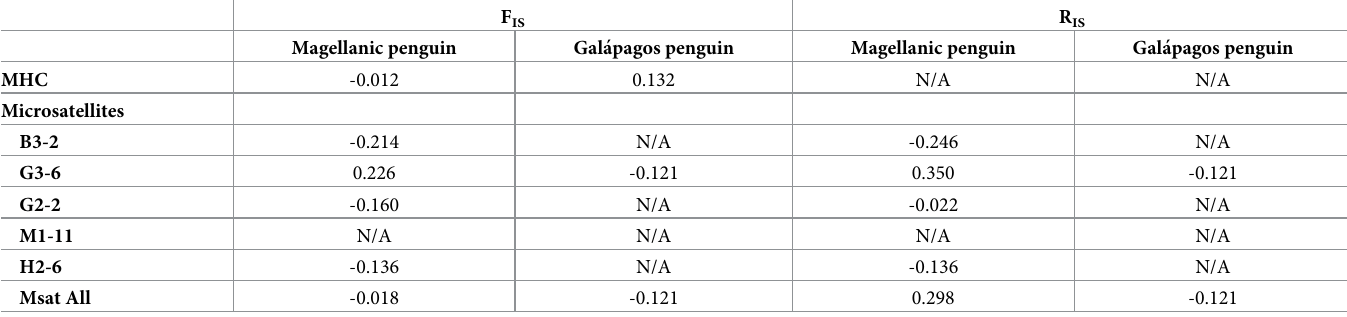
Magellanic penguin alleles (i.e., none of the alleles were shared between the two species). There were 37 polymorphic sites in the Magellanic penguin MHC alleles, whereas the Gala´pagos pen- guin MHC revealed only nine polymorphic sites (Table 1). The two alleles from the Gala´pagos penguin were found at relatively high frequencies (0.605 and 0.395). The observed heterozy- gosity was significantly higher in the Magellanic penguin (0.923) compared to that of the Gala´- pagos penguin (0.421), although there was no deviation from Hardy-Weinberg equilibrium observed for either sample set (both P > 0.5, Table 1). However, the F for the Magellanic pen- IS guin was -0.012 and for the Gala´pagos penguin was 0.132, a trend consistent with expectations for large, outbred versus small, possibly inbred populations (Table 2). Analysis of Magellanic penguin MHC sequences revealed higher rates of nonsynonymous ( d ) than synonymous ( d ) substitutions for the entirety of exon 2, and the PBR and non-PBR, N S resulting in d / d ratios significantly larger than one (all P < 0.01; Table 3). For the Magellanic N S penguin samples, the PBR had the highest d value (0.198), although this region also had the N highest d value (0.021), resulting in a d / d ratio of 9.429. Similar to the Magellanic penguin S N S samples, the Gala´pagos MHC had significantly higher d than d values along the entirety of N S exon 2 and for the PBR (both P � 0.01). Since there were no synonymous substitutions detected in the Gala´pagos penguin samples, we could not calculate a d / d ratio for this spe- N S cies. Similar to the Magellanic penguin, the Gala´pagos penguin samples had the highest d N value (0.164) within the peptide-binding region. Overall, the Magellanic penguin showed con- sistently higher d values than the Gala´pagos penguin across all regions of exon 2. All Z-tests N of positive selection were significant for all assessments ( P � 0.011) except for the Gala´pagos non-PBR ( P = 0.163). Tajima’s D estimates were greater than 2 and significant for both species [Magellanic: drift equilibrium. The Ewens-Watterson test did not reveal significant differences from neutral expectations, although the difference between the observed and expected homozygosity statis- tics was found to be greater, but only marginally significant ( P = 0.091) in the Gala´pagos pen- guin (Table 4). Table 2. F IS and R IS estimates for Magellanic and Gala´pagos penguin samples for MHC class II DR β 1 and microsatellite loci. Overall statistics for the microsatellite loci are denoted as Msat All. N/A represent monomorphic microsatellite loci. F IS R IS Magellanic